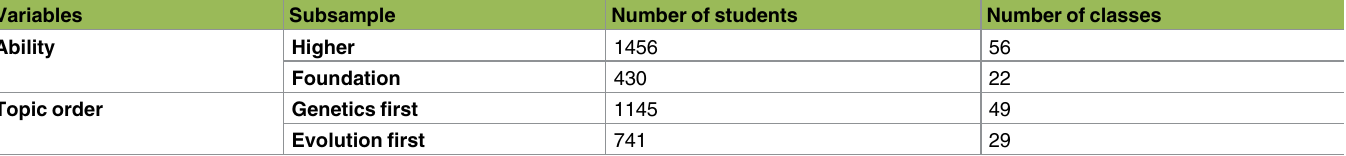
Table 7. Sample sizes for variables of key